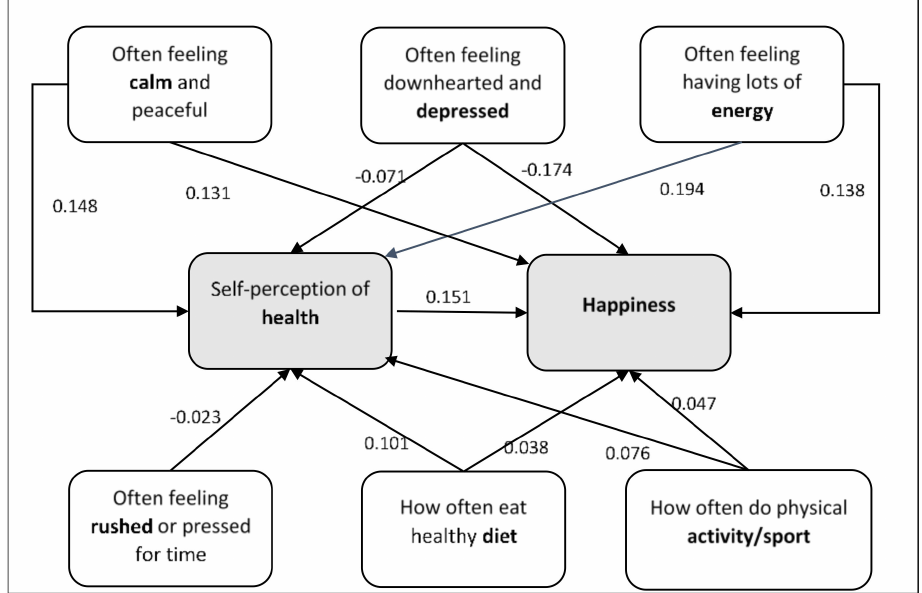
Figure 1. The final path